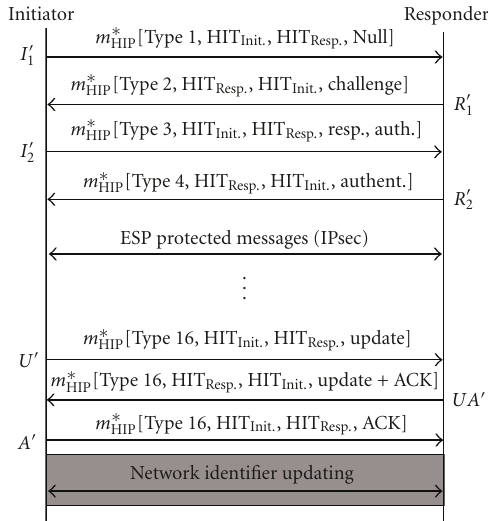
Figure 2: Modified message exchanging between initiator and responder based on